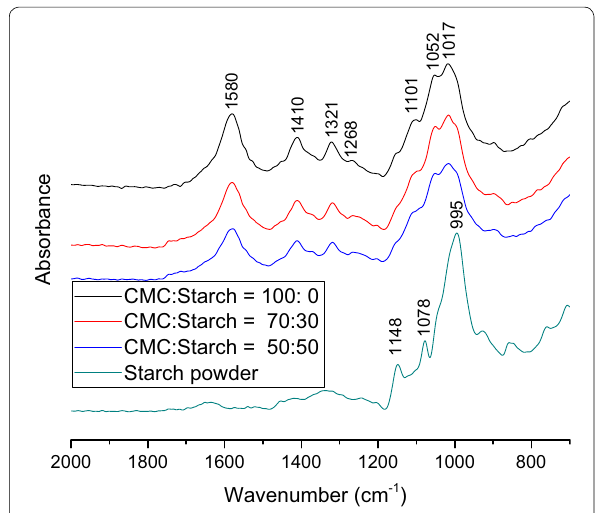
Fig. 3 FTIR-ATR spectra of various freeze-dried CMC/starch gels (20 w/w%, 20 kGy) and starch powder